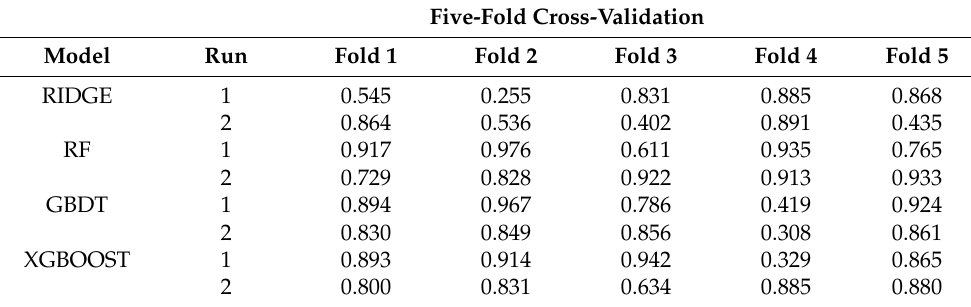
Table 3. Cross-validation of test sample results.